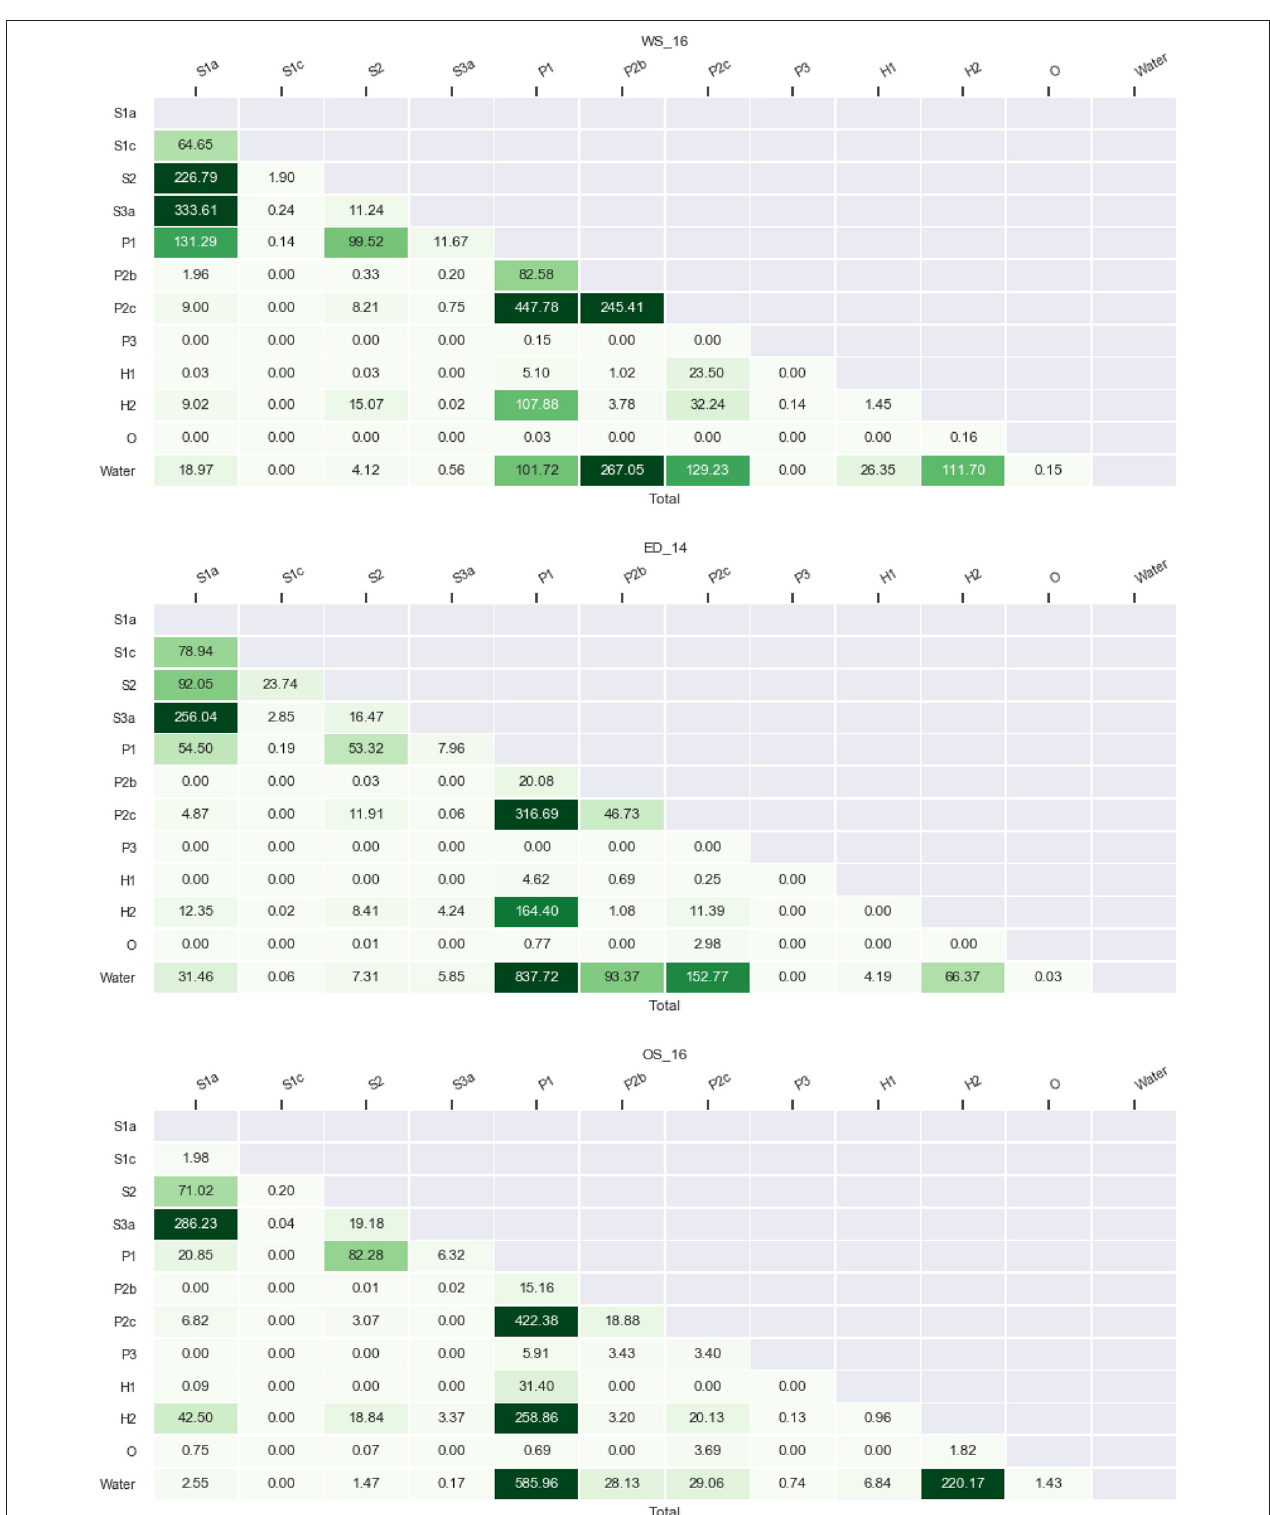
FIGURE 8 | Absolute lengths of transitions between biogeomorphological surface classes in km for the Western Scheldt (top) , Eems-Dollard (middle) , and Eastern Scheldt (bottom) . For explanation of classes see Table 2 . The color is linearly scaled with the numbers.